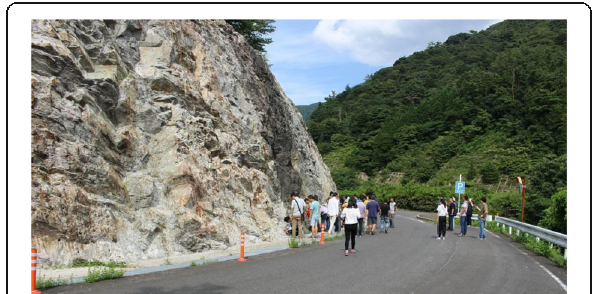
Fig. 1 Investigation on the Oki gneiss outcrop